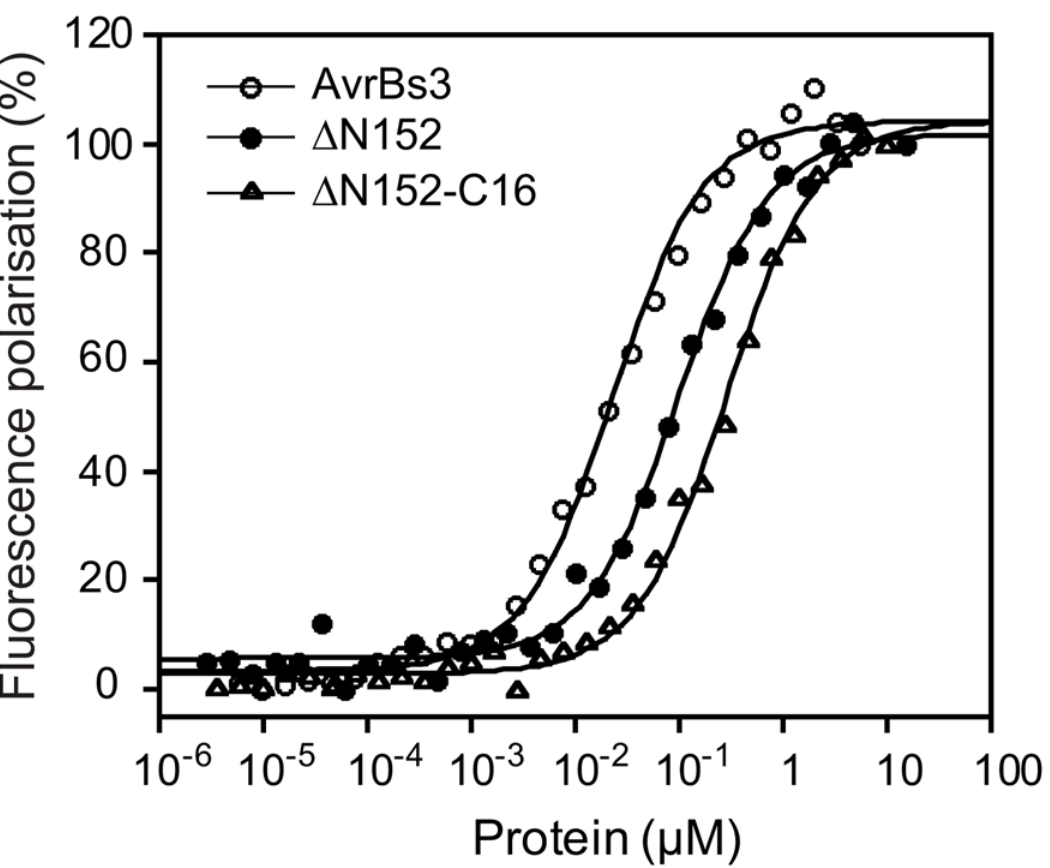
Fig 7. AvrBs3 NTR and CTR contribute to DNA binding to different extents. Fluorescence polarization titrations of fluorescein-labeled dsDNA by AvrBs3 and deletion mutants. Increasing concentrations of purified His 6 -tagged AvrBs3 (open circles), AvrBs3 Δ N152 (closed circles) and AvrBs3 Δ N152-C16 (CTR deleted, except for the first 16 aa downstream of the repeats; open squares) were incubated under reducing conditions with fluorescein-labeled 36-bp DNA fragments derived from the UPA20 promoter. Fluorescence polarization intensities were normalized and plotted as function of protein concentration. The results are representative of three independent measurements. Dissociation constants (K Dapp ) were determined by curve fitting with a one-site saturation and nonspecific binding model using Kaleidagraph 4.0 (Synergy Software). The K Dapp for AvrBs3 is 23.2 ± 1.6 nM, and K D values of 99.2 ± 7.5 nM and 282.2 ± 18.1 nM were calculated for the truncated derivatives AvrBs3 Δ N152 and AvrBs3 Δ N151-C16,